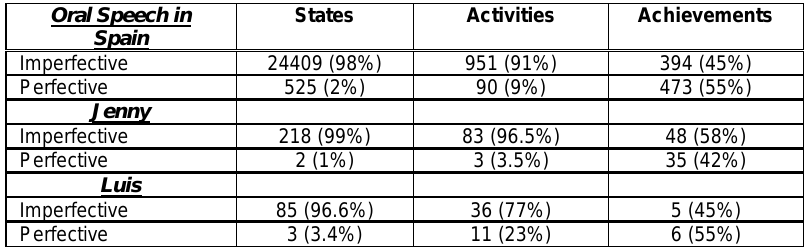
Table 7: Comparison of the distributions of verb forms (raw numbers and percentages) according to imperfective (present, imperfect) and perfective (preterit) verb forms in oral speech in Spain, Jenny’s speech, and Luis’